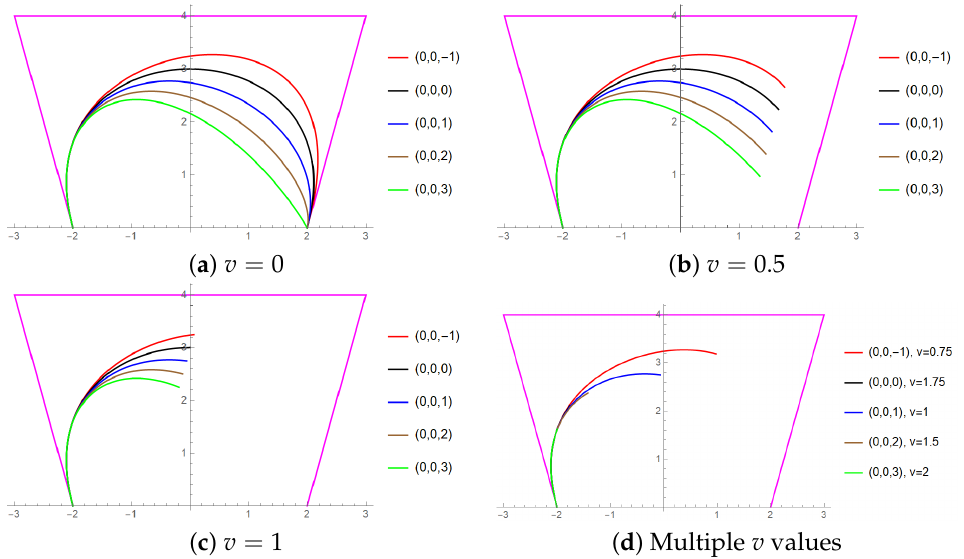
Figure 5. Cubic fractional Bézier curve with multiple values of v and a 3 shape